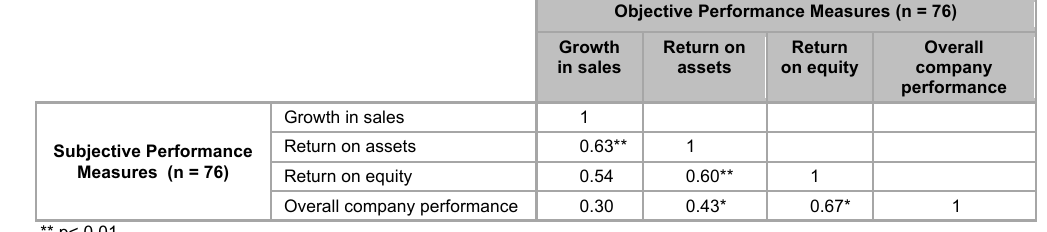
Objective Performance Measures (n = 76) Growth Return on Return Overall in sales assets on equity company